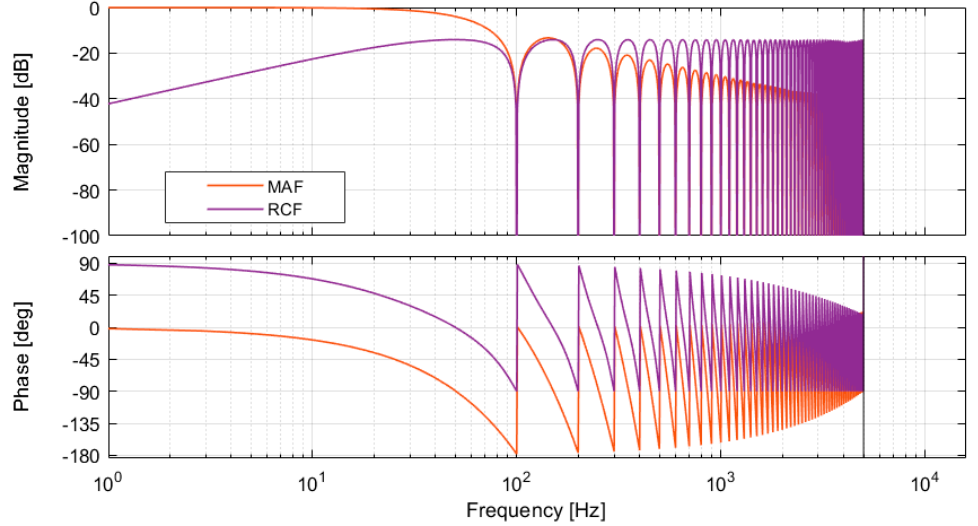
Figure 3. Bode plots of moving average filter (MAF) and repetitive control filter (RCF) (parameters are selected according to Table 2).